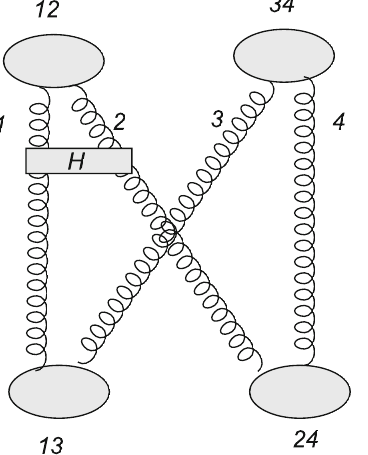
Fig. 3 Contribution from the interaction inside the pomerons P 12 . Three others should be added with interactions inside P 34 , P 13 and P 24 As a result the contribution D